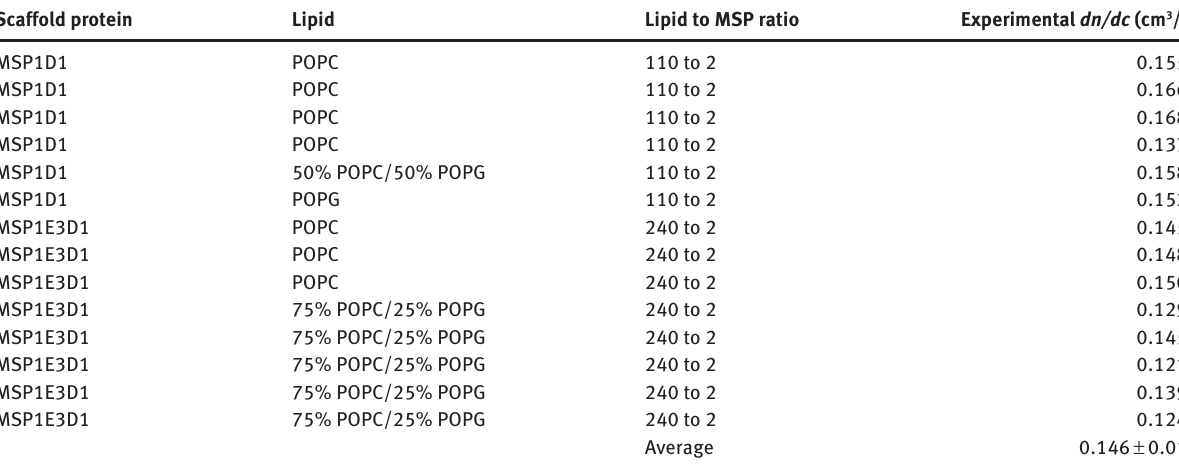
Table 1: Determination of dn/dc for lipids in empty nanodiscs a . Scaffold